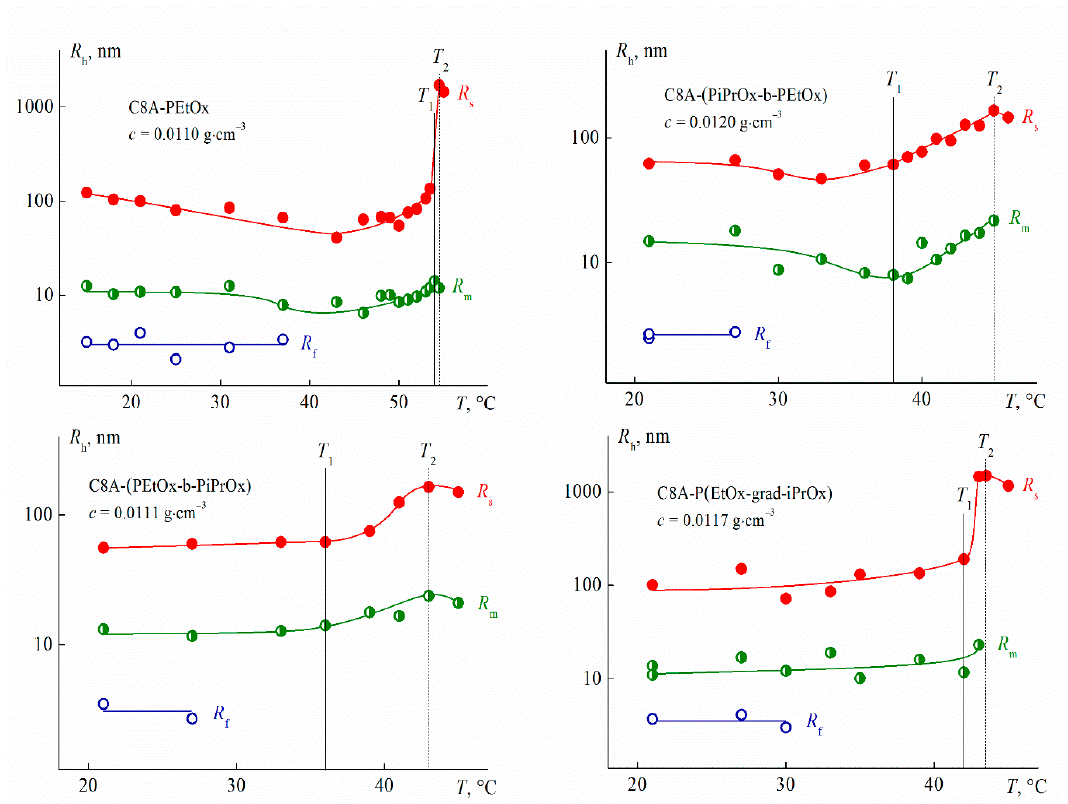
Figure 9. Temperature dependences of hydrodynamic radii R h of scattering particles for aqueous solutions of C8A-PAlOx.